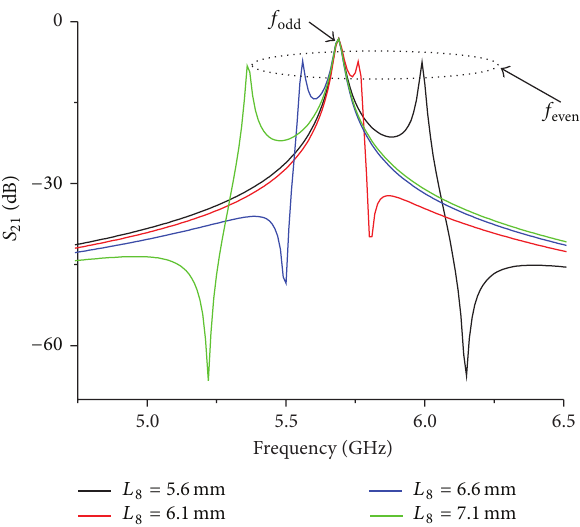
Figure 2: Simulated return loss (𝑆 21 ) of the TSSLR.